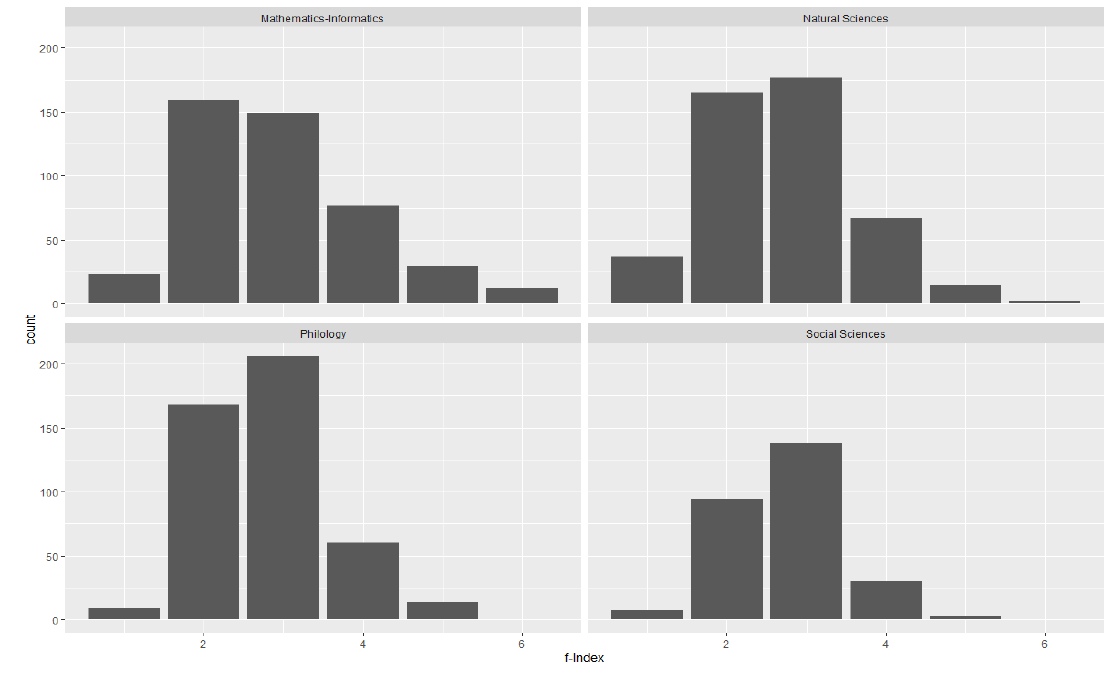
Figure 5. f -index by specialisation.